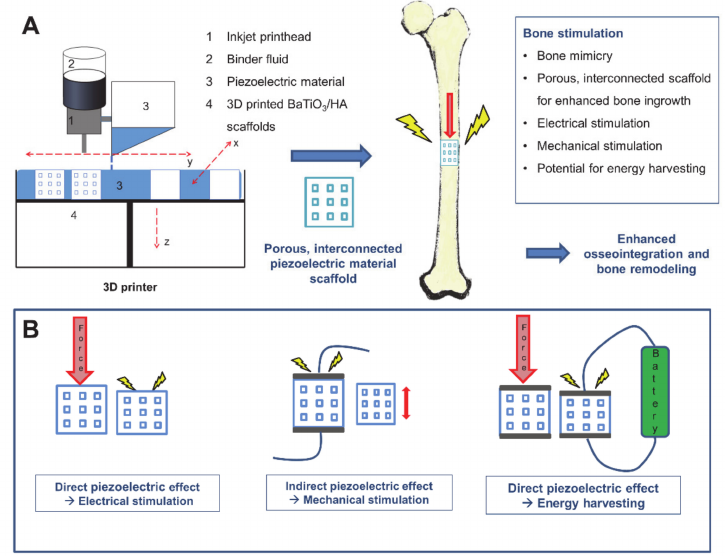
Figure 1. Overview of 3D printing of piezoelectric materials for bone stimulating implants. ( A ) shows exemplarily the binder jetting process used for the fabrication of piezoelectric sca ff olds. ( B ) indicates di ff erent applications of the piezoelectric e ff ect for bone stimulation. Piezoelectric implants have the potential to stimulate electrically (direct piezoelectric e ff ect), mechanically (indirect piezoelectric e ff ect) or could be used as an energy harvesting device to power other implants or